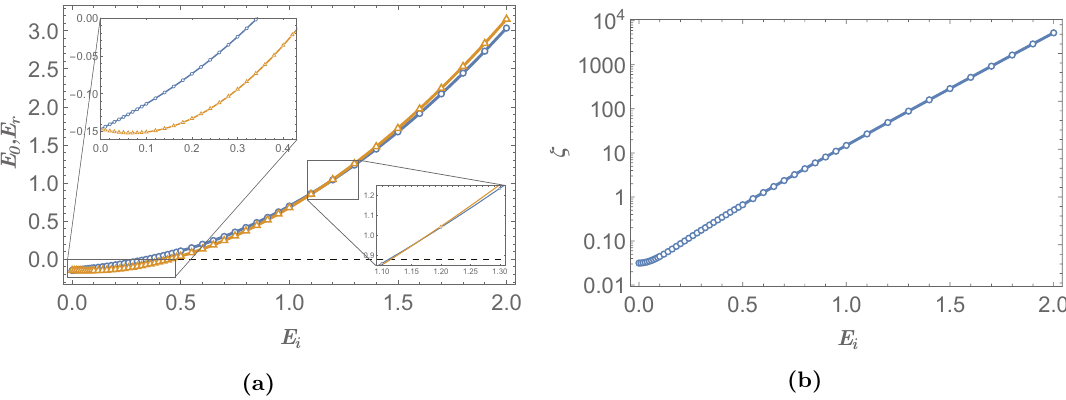
Figure 11. (a) The numerical solution of E 0 (blue) and E r (yellow) as a function of E i . As E i increases, E 0 increases monotonically and E r decreases in the beginning then increases. At around E i ≈ 1 . 2 , E r becomes larger than E 0 . (b) The numerical solution of ζ as a function of E i . As E i increases, ζ increases exponentially. In both pictures, we set 2 φ b = 1